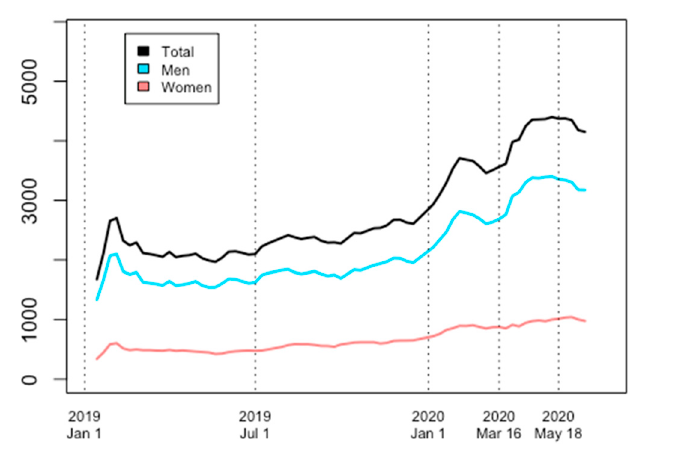
Figure 1. Number of individuals self-excluded for a one-month interval on every Monday, 1